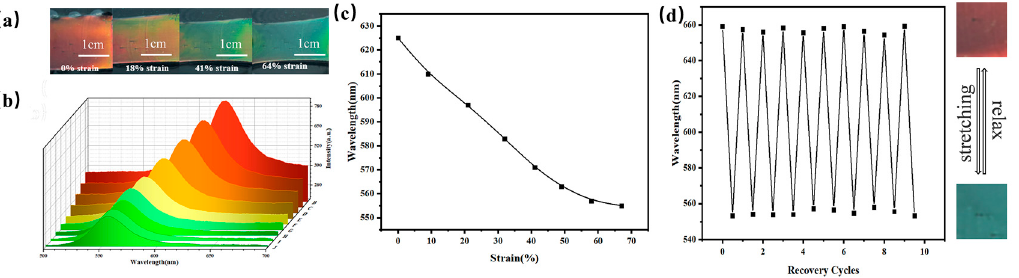
Figure 8. ( a ) Optical photograph of 3D O-(A- β -CD)-AM PC during stretching; ( b ) corresponding reflection spectra during stretching; ( c ) variation of reflected wavelength with increasing tensile force; (d) cyclability of 3D O-(A- β -CD)-AM PC.